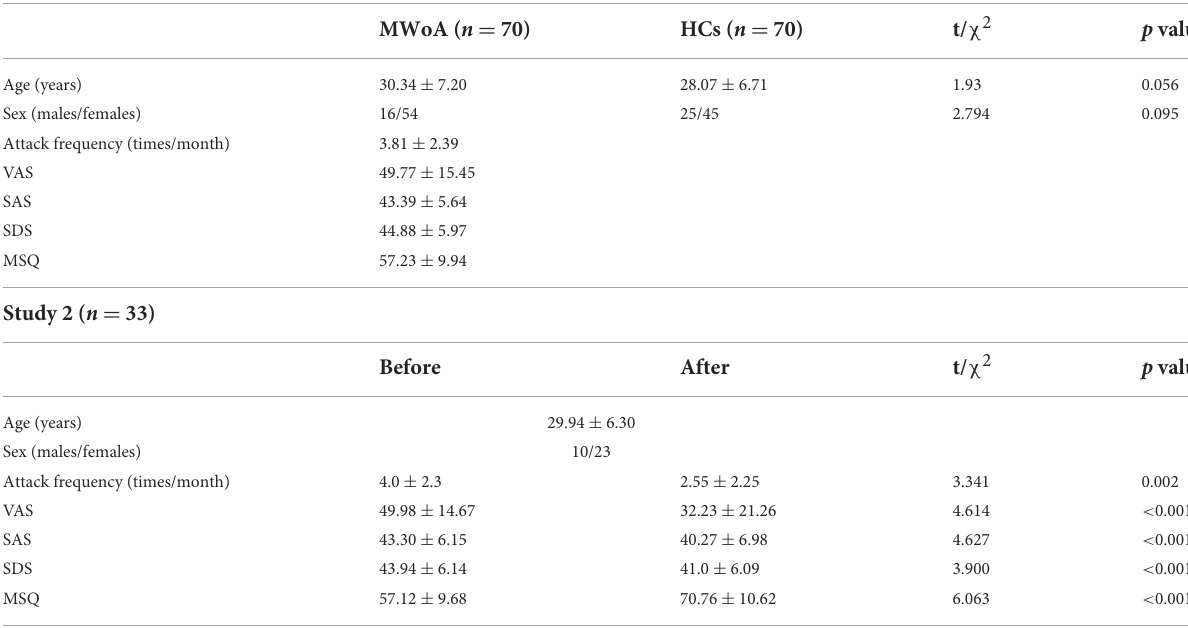
TABLE 1 Characteristics of each subject group.